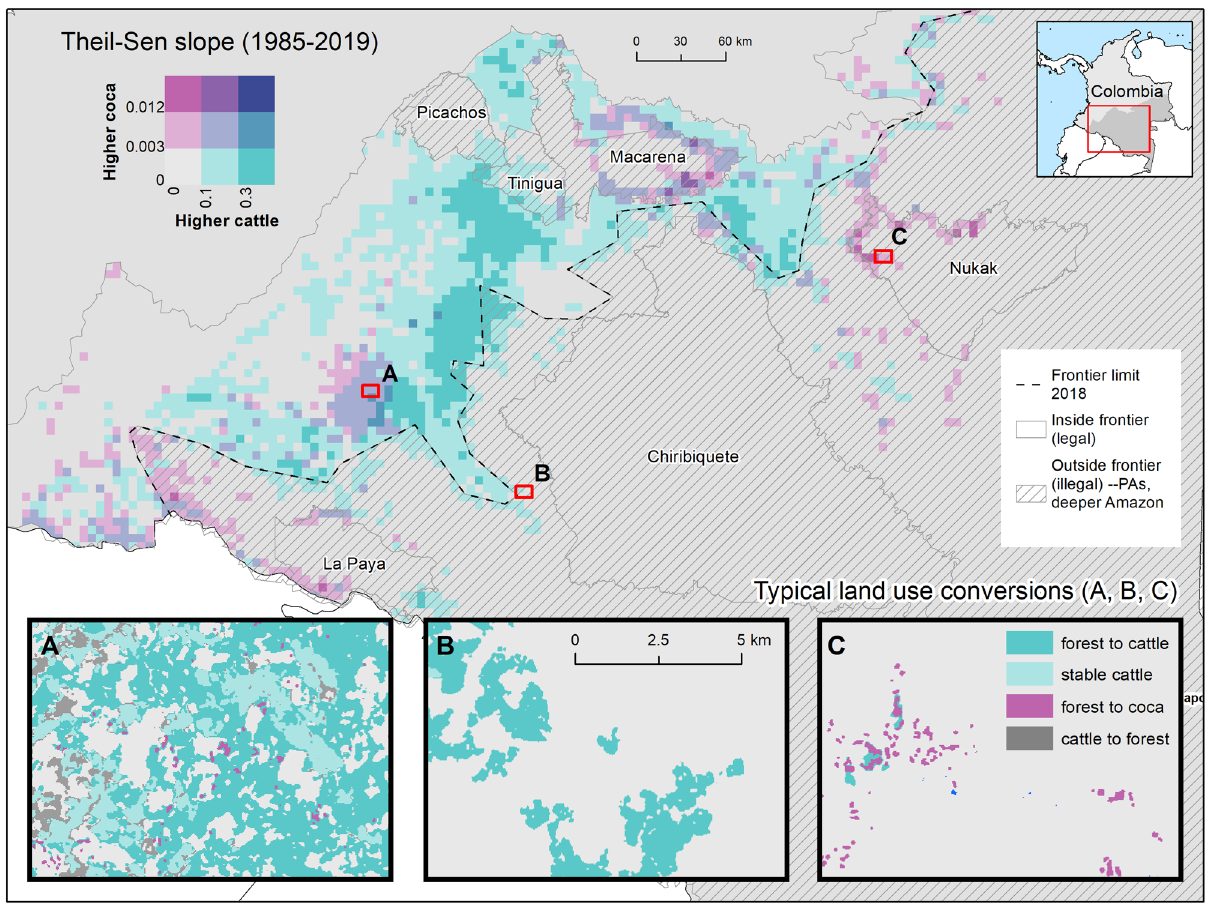
Figure 2. Trends in land conversion in the Colombian Amazon. Mapped area of coca and cattle was aggregated to 5 km cells, and trends in area were summarized using the Theil Sen slope calculation. ( A ) Region with transition from coca to new large cattle lands. ( B ) Large-scale illegal conversion past the agricultural frontier, deeper into the Amazon. ( C ) Coca plots expansion within the Nukak Makú indigenous reserve. Map created in QuantumGIS 3.16 (https:// www. qgis. org/ en/